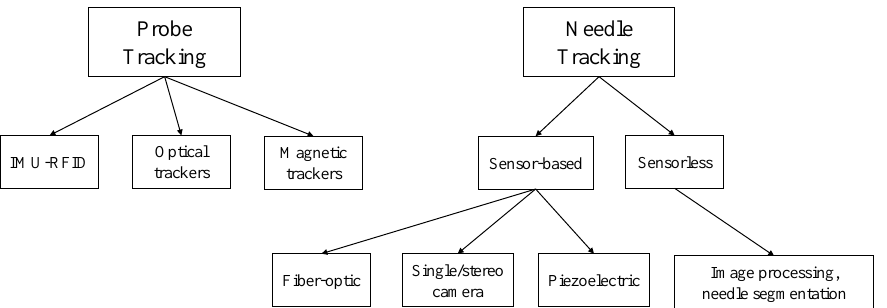
Figure 3. The classification of tracking methods for the ultrasound probe and for the surgical